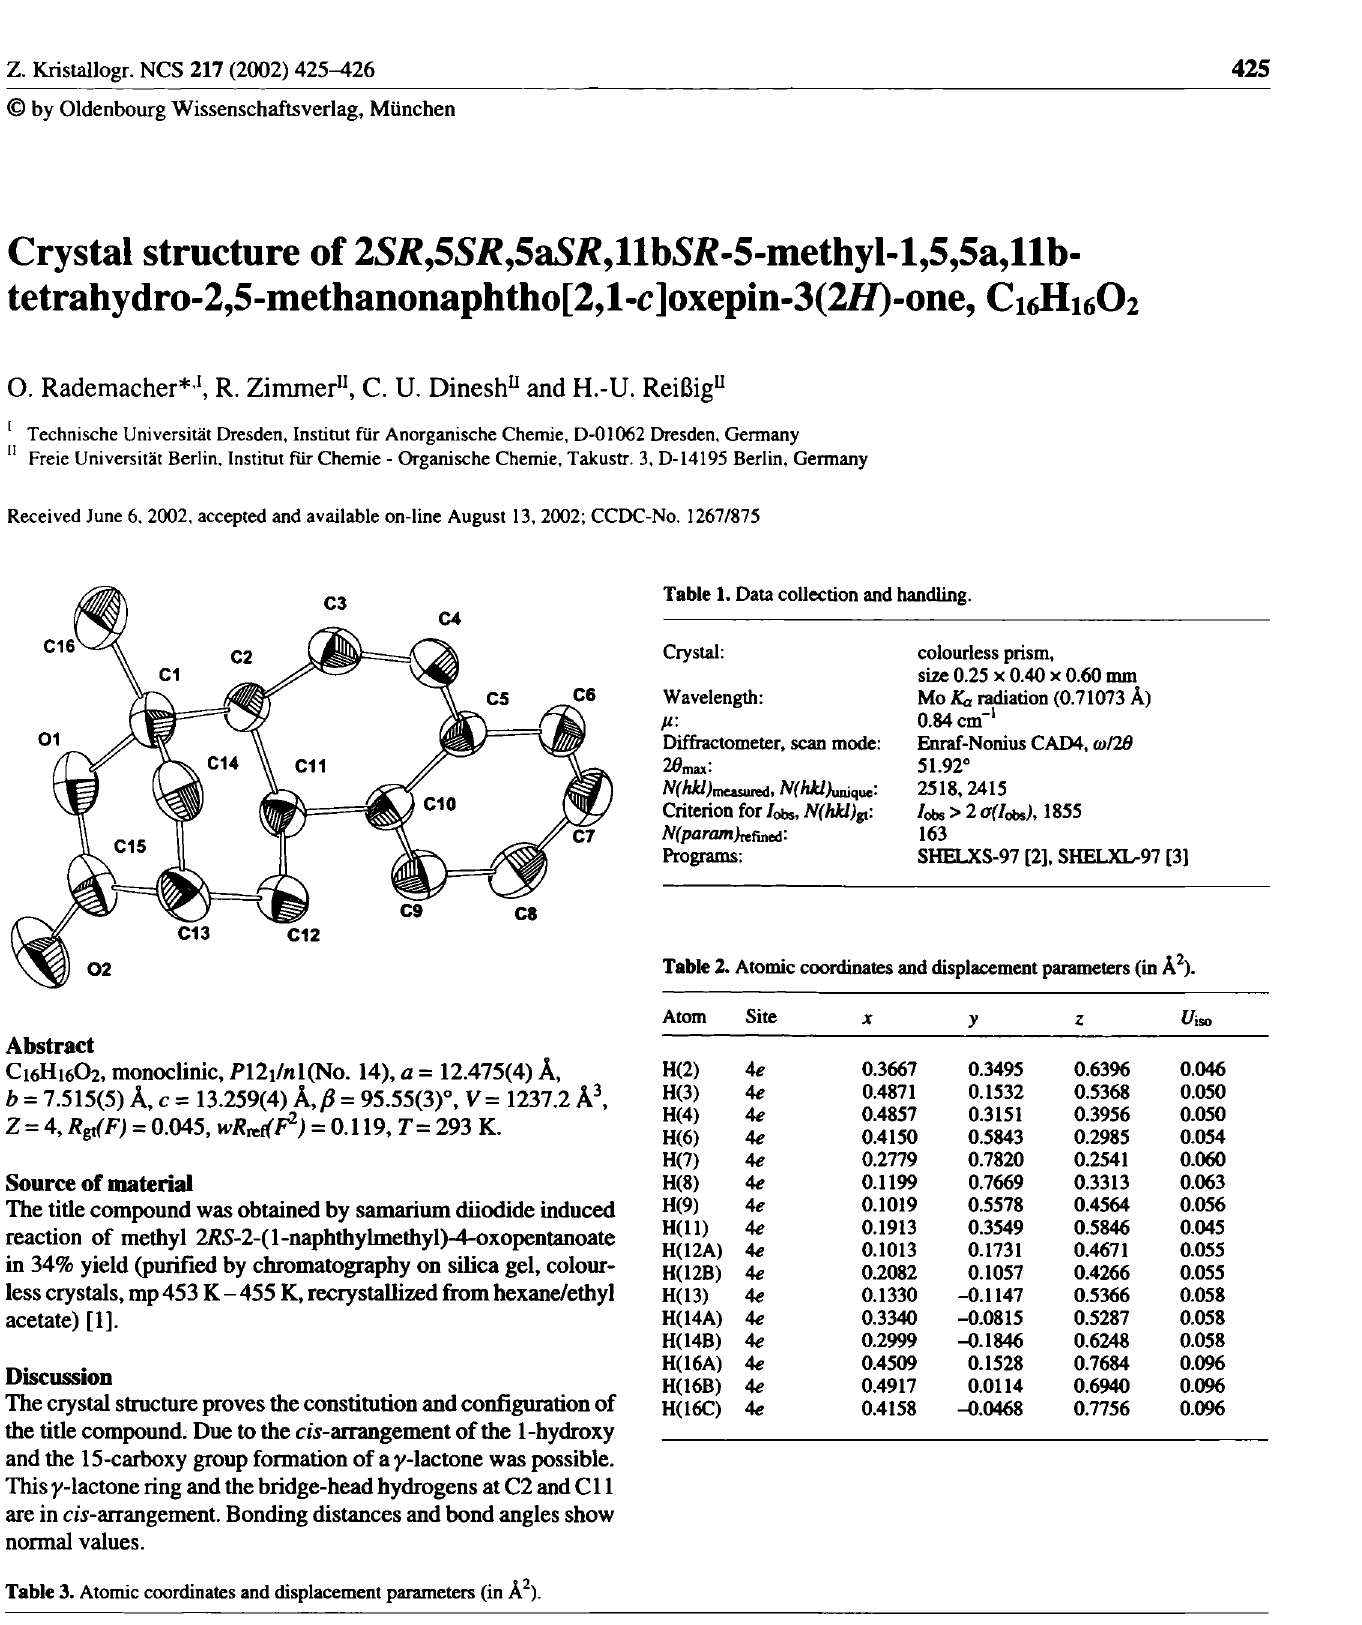
Table 3. Atomic coordinates and displacement parameters (in Ä 2 ).